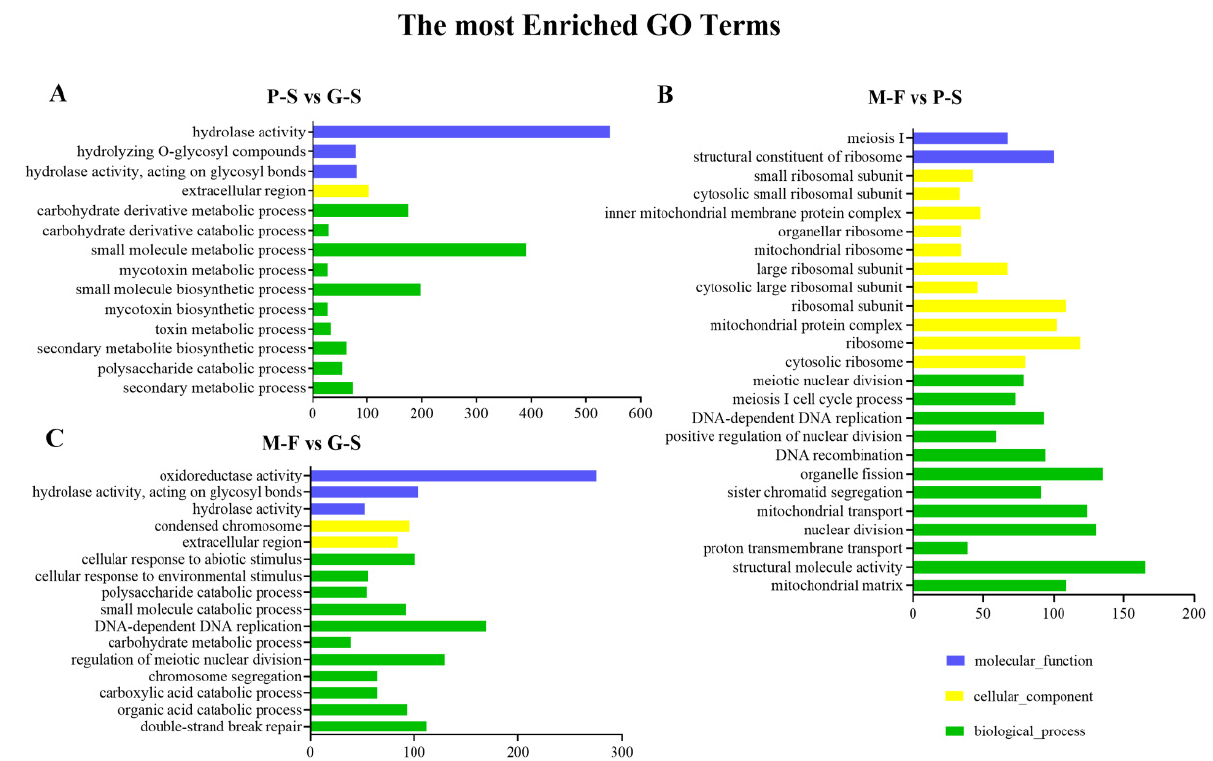
Figure 3. GO functional classification of DEGs. ( A – C ) GO enrichment between different growth and development stages. The green bars represent biological processes; yellow bars represent cellular components; blue bars represent molecular functions. Only the significant GO terms ( p < 0.005) are shown.